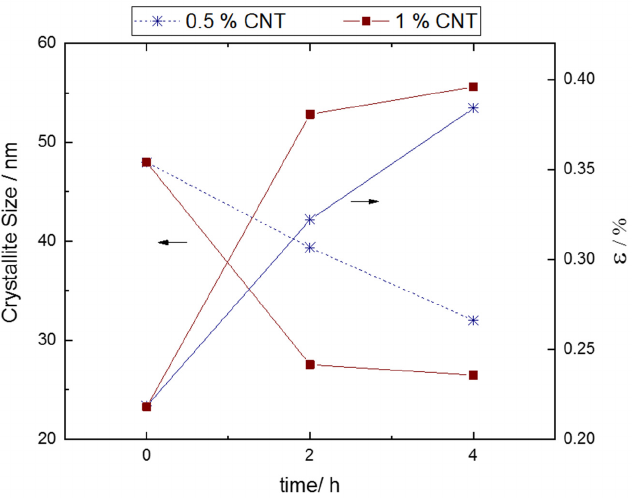
Figure 10. Variation in crystallite size and lattice strain in composite powders as a function of milling time.